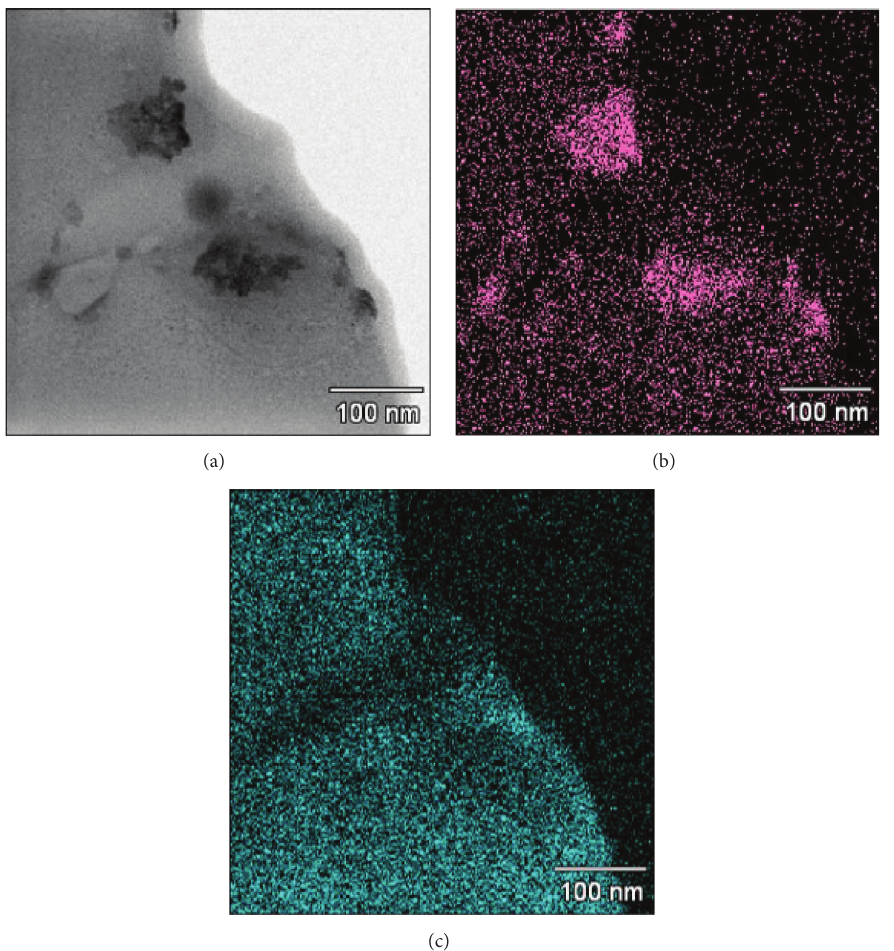
Figure 11: (a) Bright field TEM image of an AR sample (the small dark dots represent GP-zones). (b) Element analysis of the GP-zones (pink dots indicate the appearance of Cu). (c) Element analysis of the GP-zones (green dots indicate the appearance of Al).